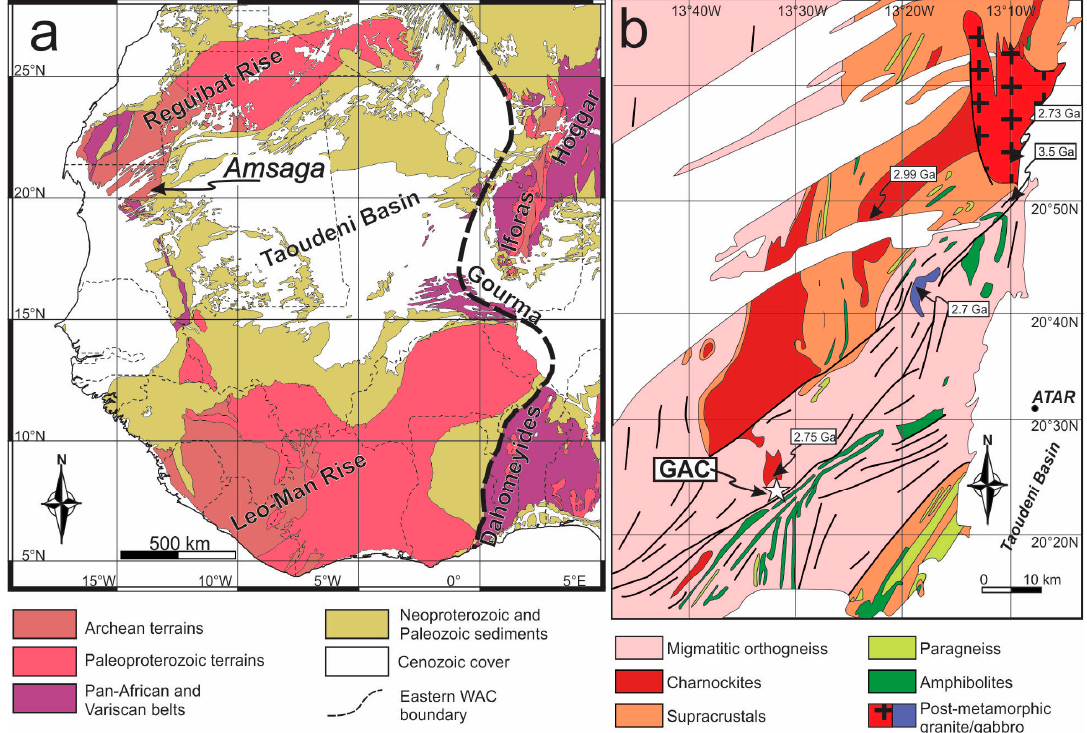
Figure 1. Geological maps of the West African Craton ( a ) and the Amsaga area ( b ). The map of Amsaga and the geochronological information are from Potrel (1996) [35]. GAC: Guelb el Aziz Complex.